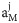
Evolution of the attitude of non-M agent (in orange) for the M agent (in blue): Dotted line, before the terrorist attack; plain line, after the agression.(a) On the left, the attitude does not change despite the change of M margin(h) of acceptance, it remains -1: the maximum change of M margin(h) is limited by aMj which is valued -1 by i in any cases. Thus the attitude of the non-M agent for the M agent can’t change; (b) On the right, the attitude decreases (from 0.23 to 0.14) due to the decreasing of the margin(h) of acceptance of the non-M agent and despite the part of the overlap over the M acceptance segment has increased. Indeed, with a smaller margin(h), the non-M agent sees the part of the inclusive M’s segment external to it strongly more negatively than before.